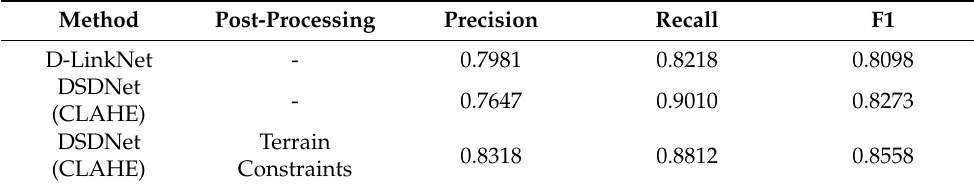
Figure 10. Diagram of point samples and OSM roads. We used a rendering method to display the DEM, so there is not a precise numerical representation, but rather high and low elevation. Table 2. Accuracy of different experimental models.